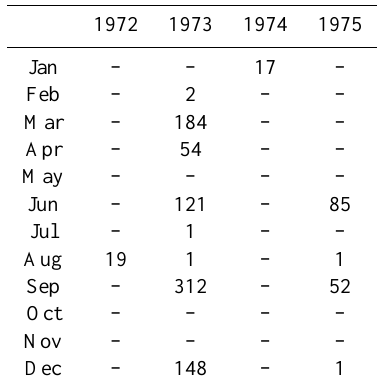
Table 1. Available topside sounder N e profiles from the ISIS-2 satellite. The table indicates the number of N e profiles available for each month (Sibanda and McKinnell, 2009).